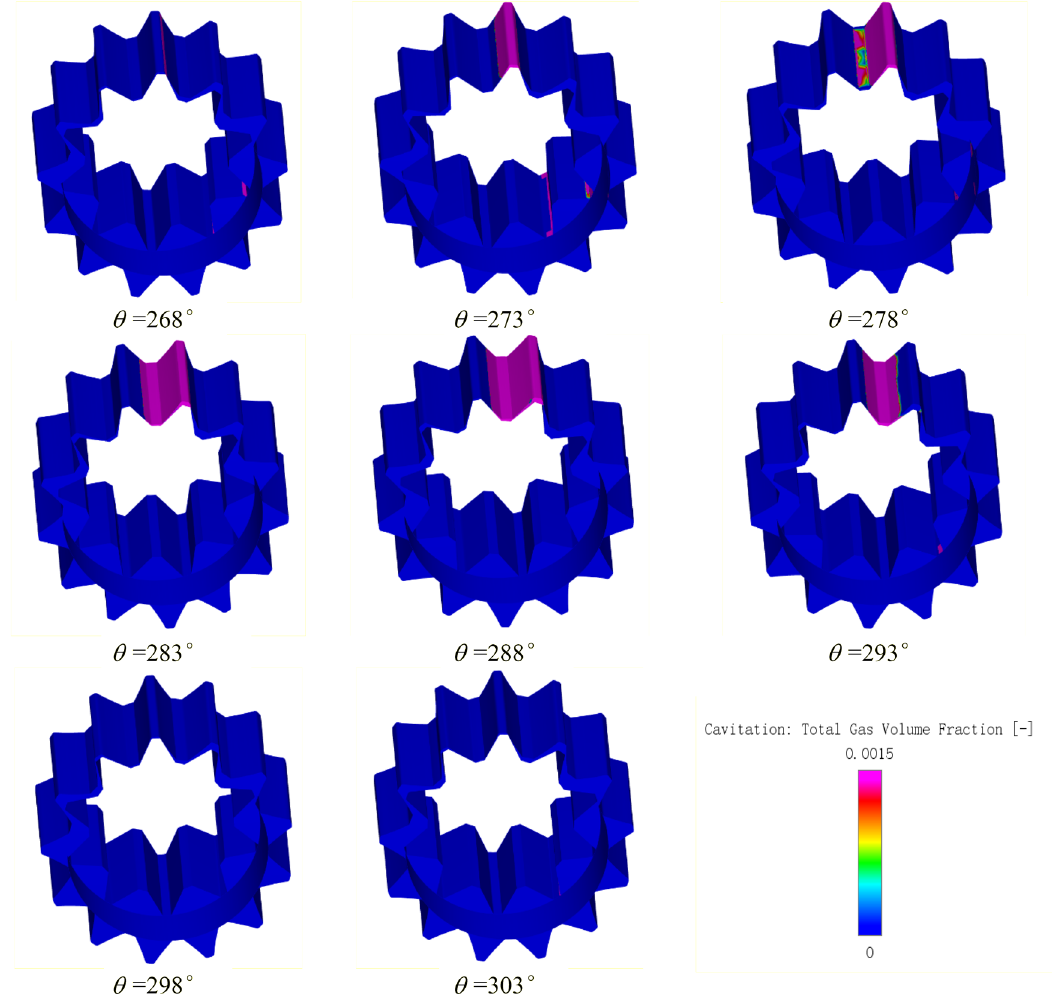
Figure 20. The cavitation fields of total gas volume fraction during a mesh cycle.